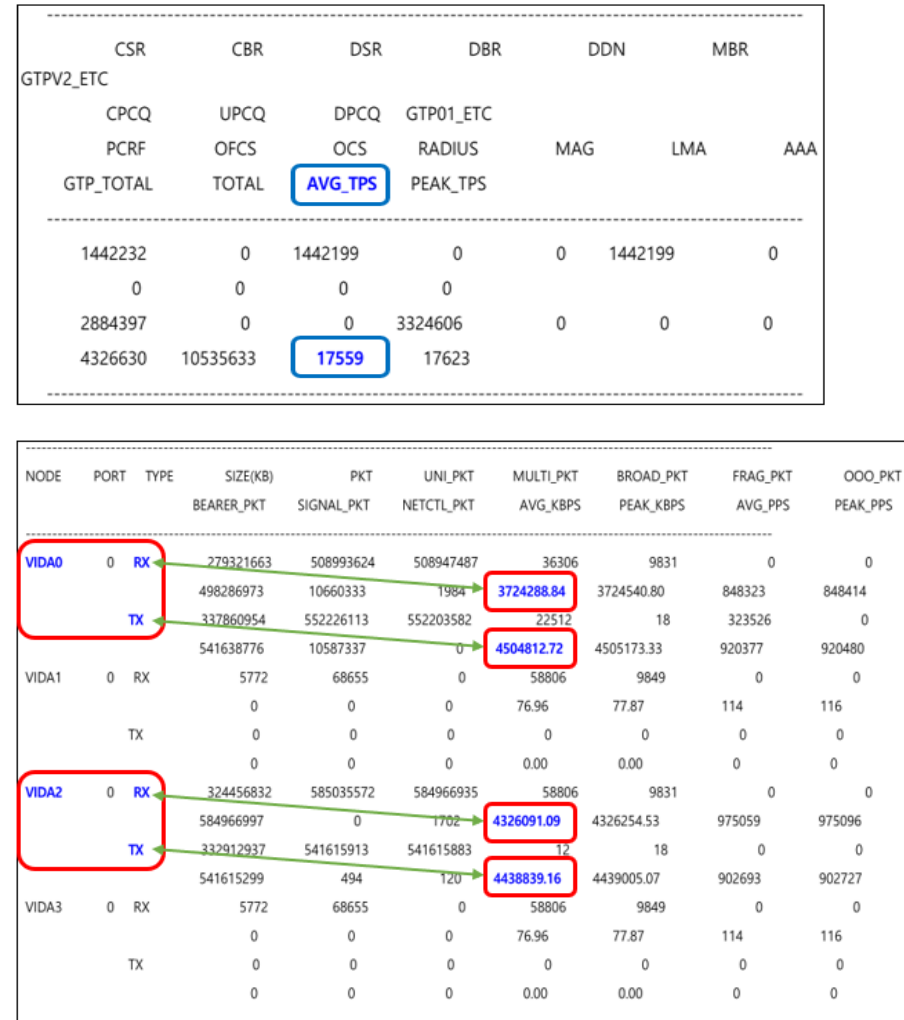
Figure 4. Test results of SAE-GW.